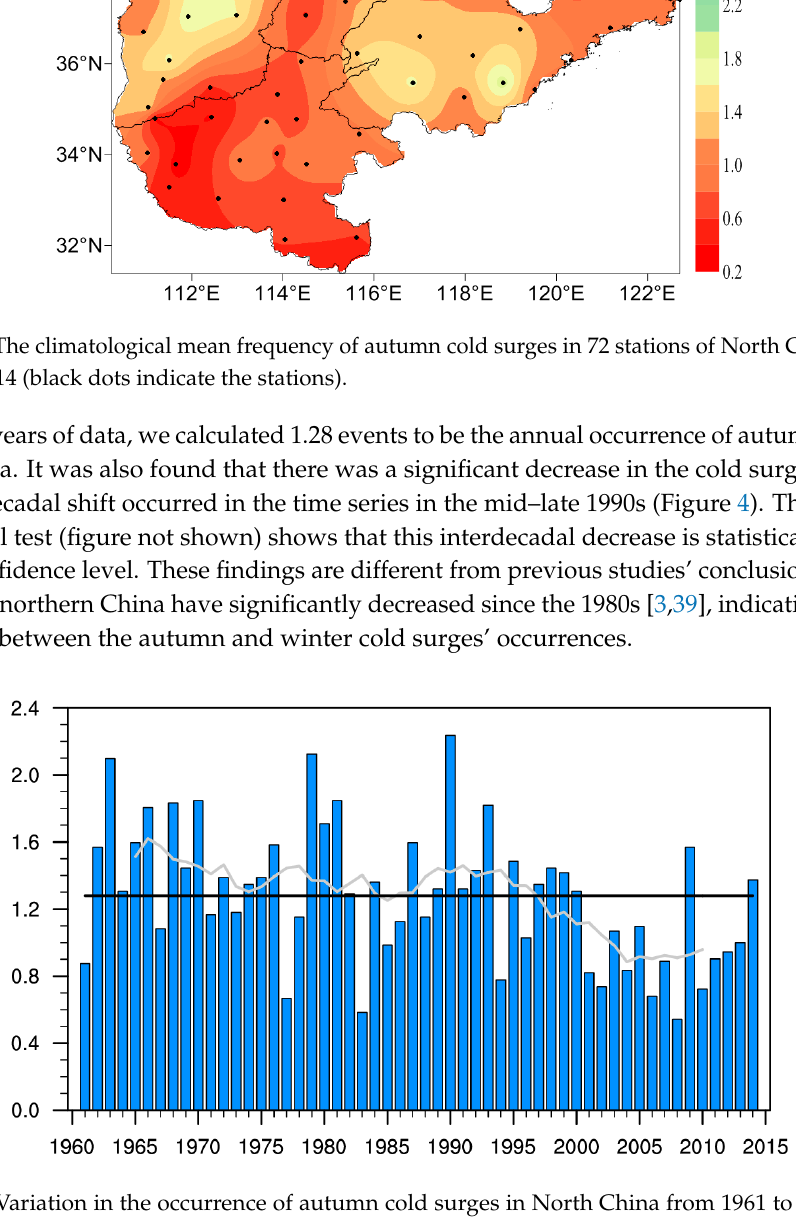
Figure 4. Variation in the occurrence of autumn cold surges in North China from 1961 to 2014. The black solid line indicates the average occurrence for the study period. The gray solid line indicates the nine ‐ year running average.